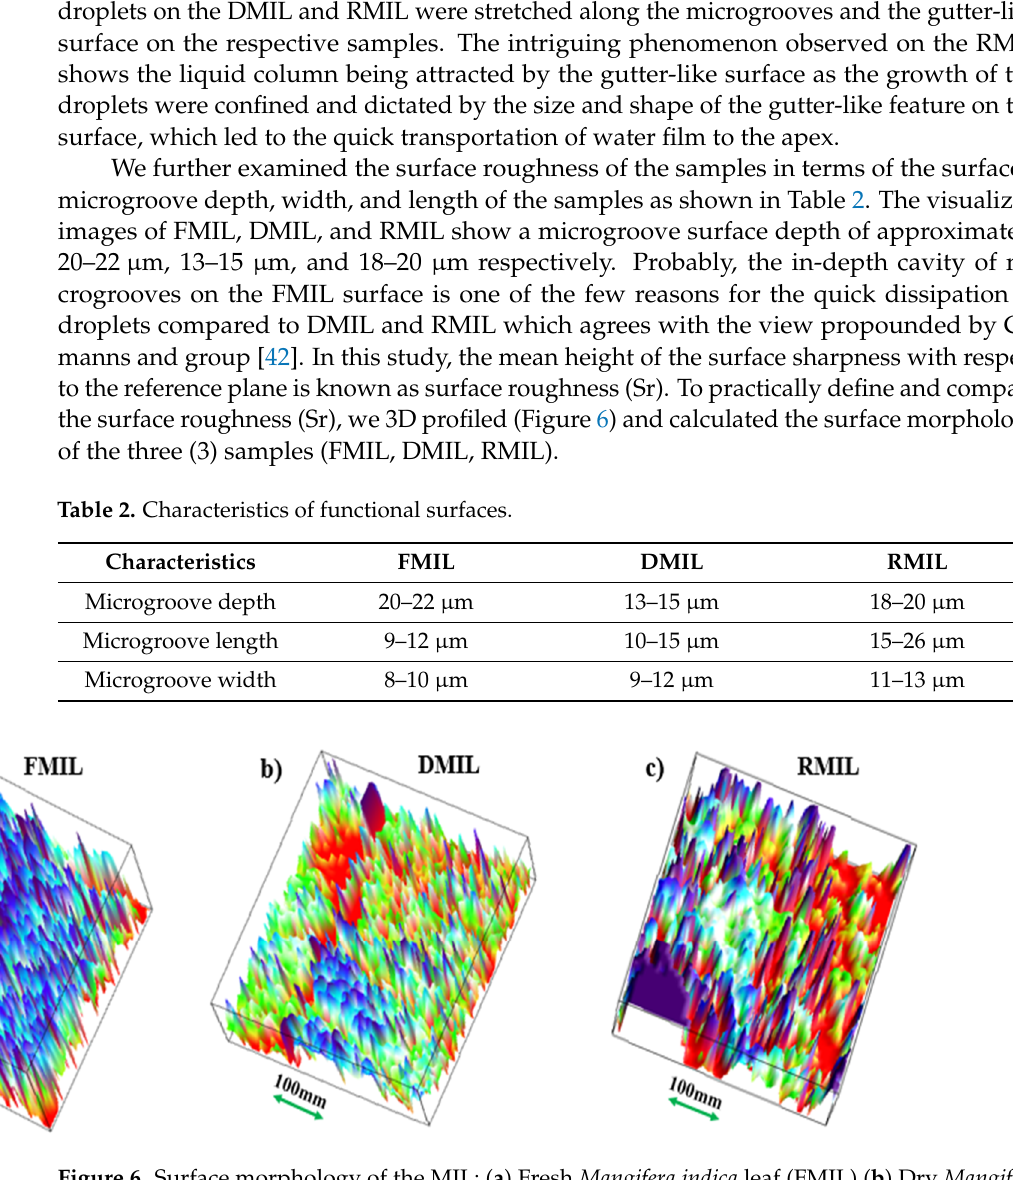
Figure 6. Surface morphology of the MIL: ( a ) Fresh Mangifera indica leaf (FMIL) ( b ) Dry Mangifera Indica leaf (DMIL), and ( c ) Replicated Mangifera indica leaf (RMIL).